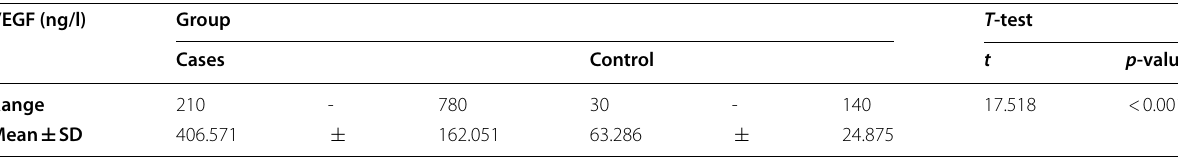
Table 3 VEGF level in case and control groups